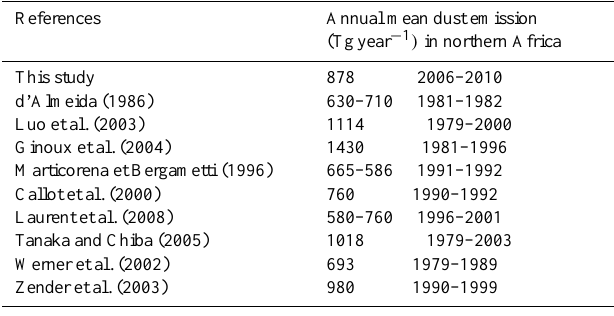
Table 2. Comparison of regional annual mean dust flux between this study and other studies. The unit is Tgyear − 1 .